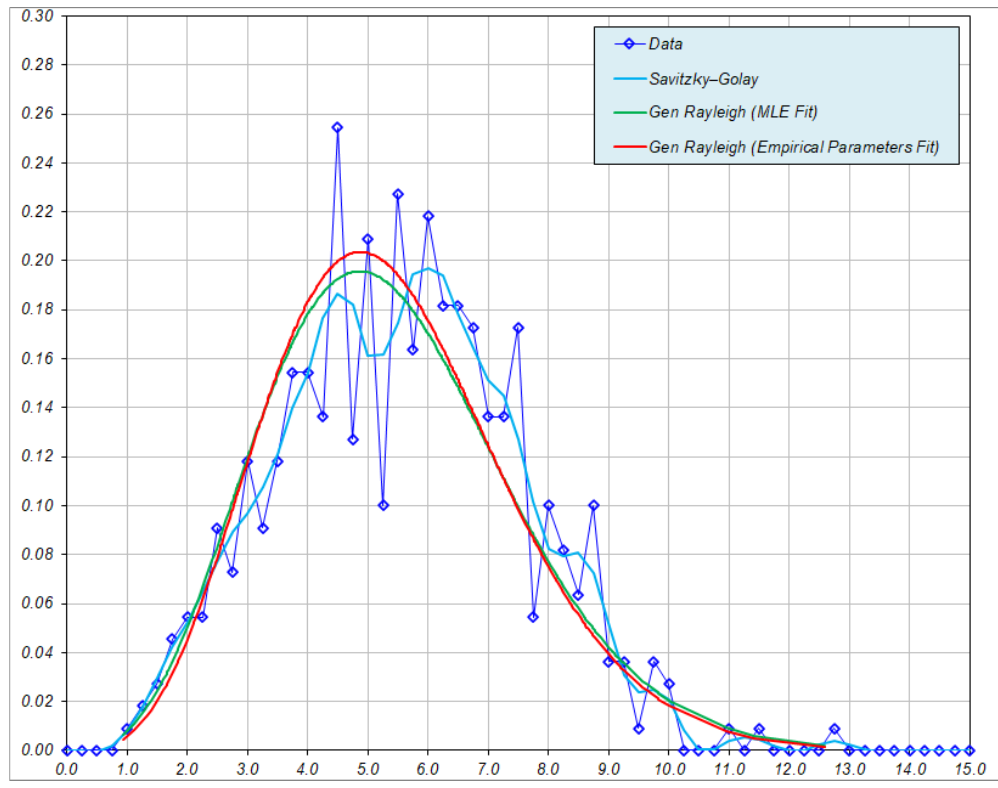
Figure 7. Probability Density Function (PDF) of the example towed seabed photograph ( 2015_08_29_131349 in Tables 2 and 3).